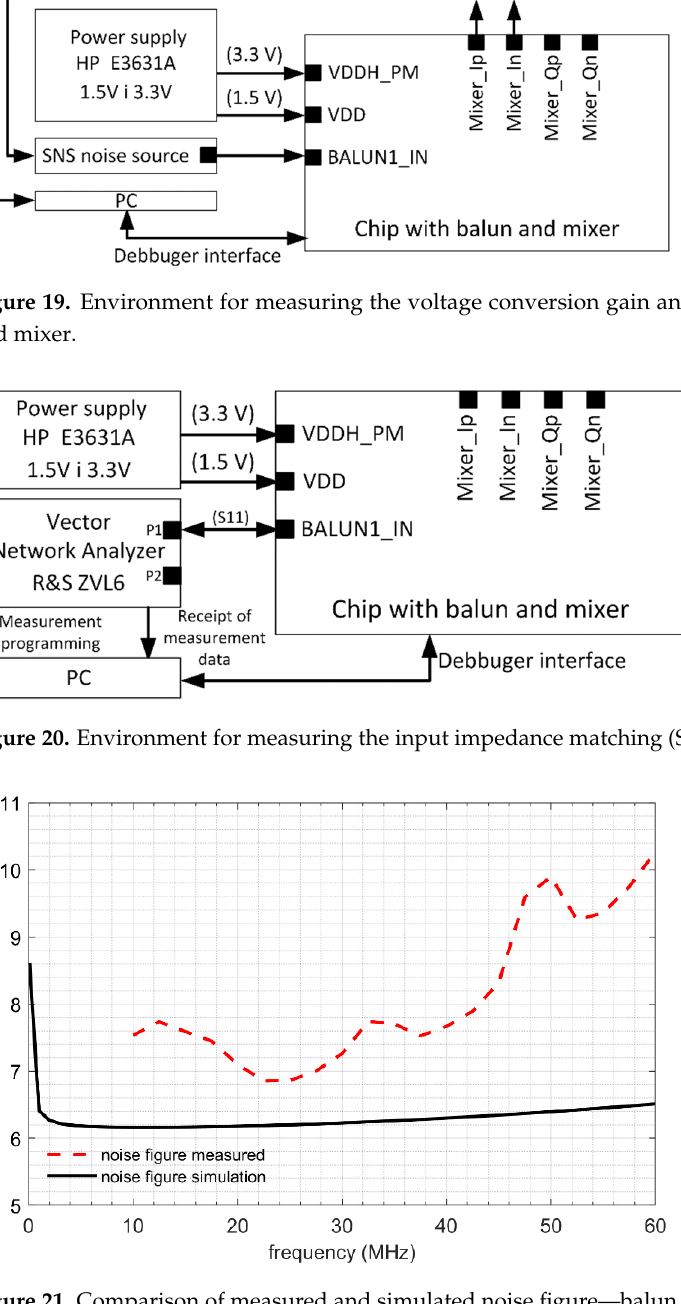
Figure 19. Environment for measuring the voltage conversion gain and noise figure of the balun and mixer.